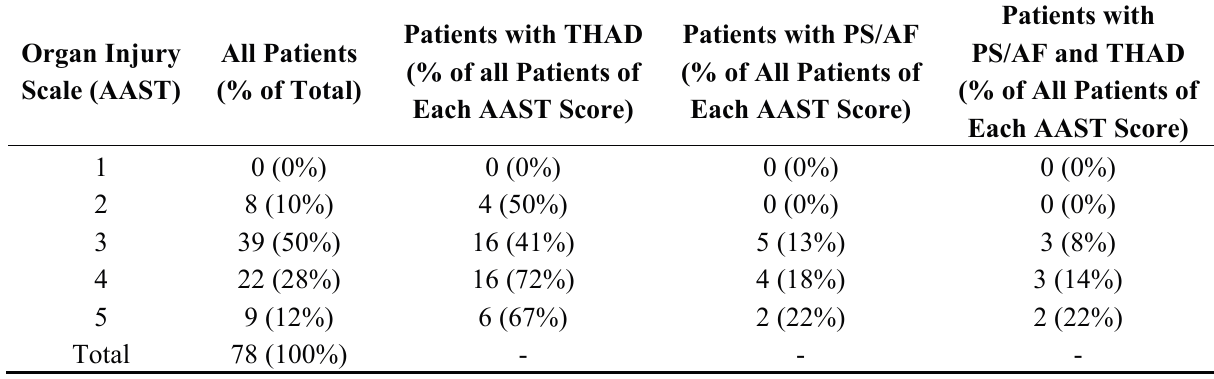
Table 4. Distribution of American Association for the Surgery of Trauma (AAST) organ injury scale for all patients, for patients with THAD, for patients with PS/AF and for patients with PS/AF and